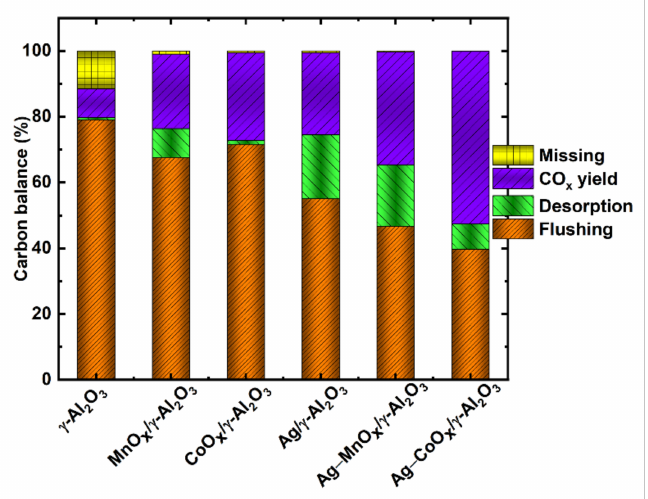
Figure 7. Carbon balance obtained during ozone